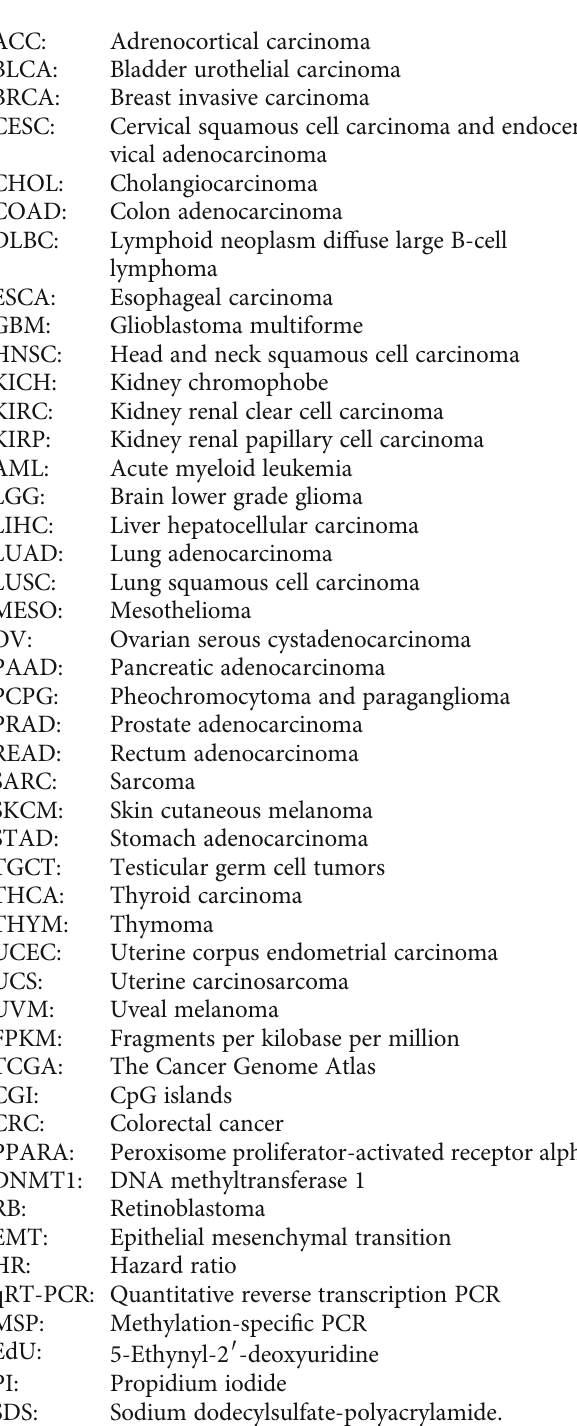
Table S1: list of primers used in the qRT-PCR assay. Table S2: list of primers used in the methylation-speci fi c PCR